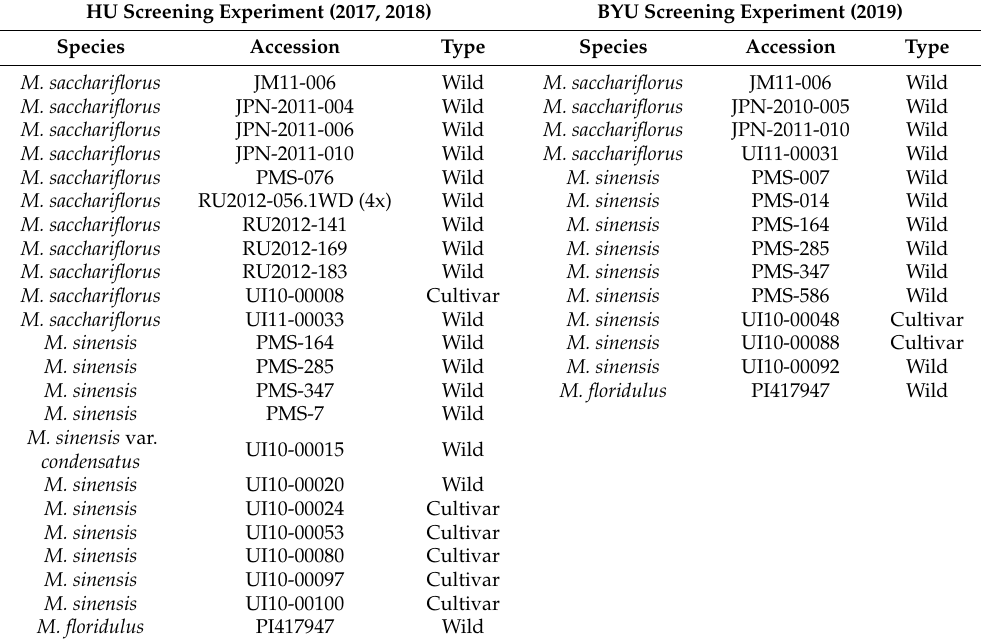
Table 1. List of Miscanthus genotypes included in screening experiments at Hokkaido University (HU), Sapporo, Japan and Brigham Young University (BYU), Provo, Utah, USA. HU Screening Experiment (2017, 2018) BYU Screening Experiment (2019) Type